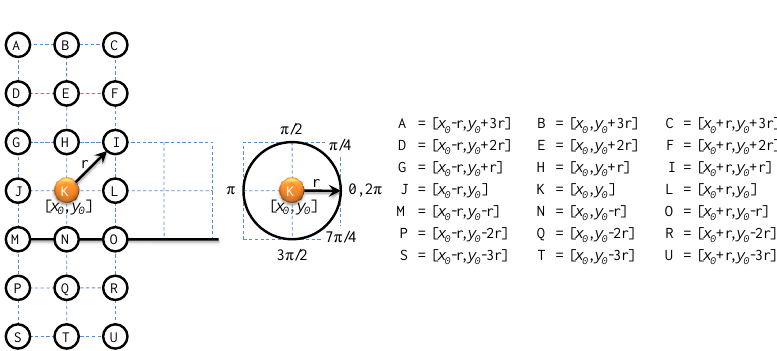
Figure 7. Mexican Spanish alphabet.